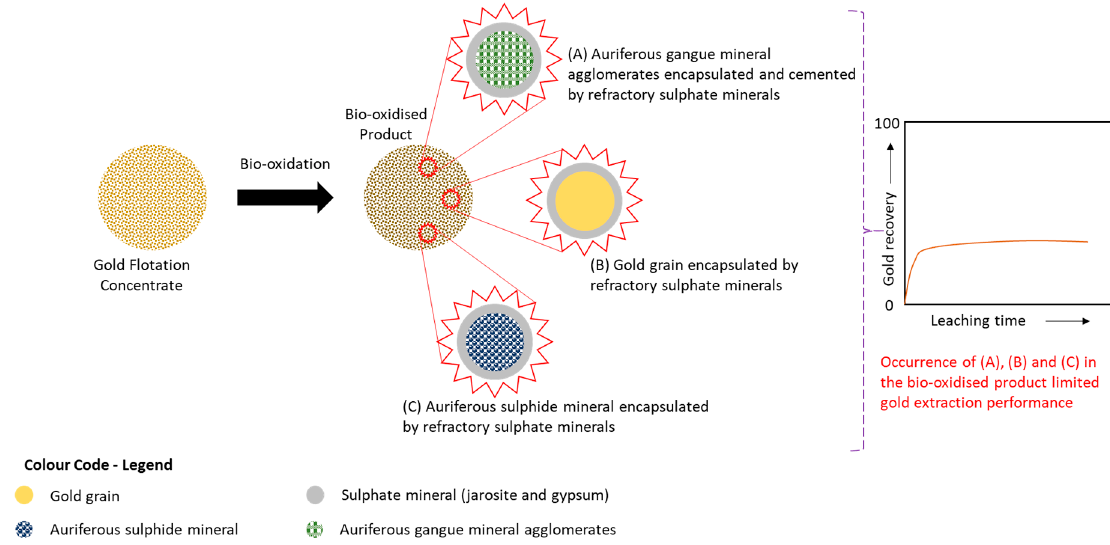
Figure 3. Schematic diagram showing the influential role of secondary sulphate minerals (gypsum, jarosite) formed after bio-oxidation on gangue minerals, auriferous sulphides, and gold grains.